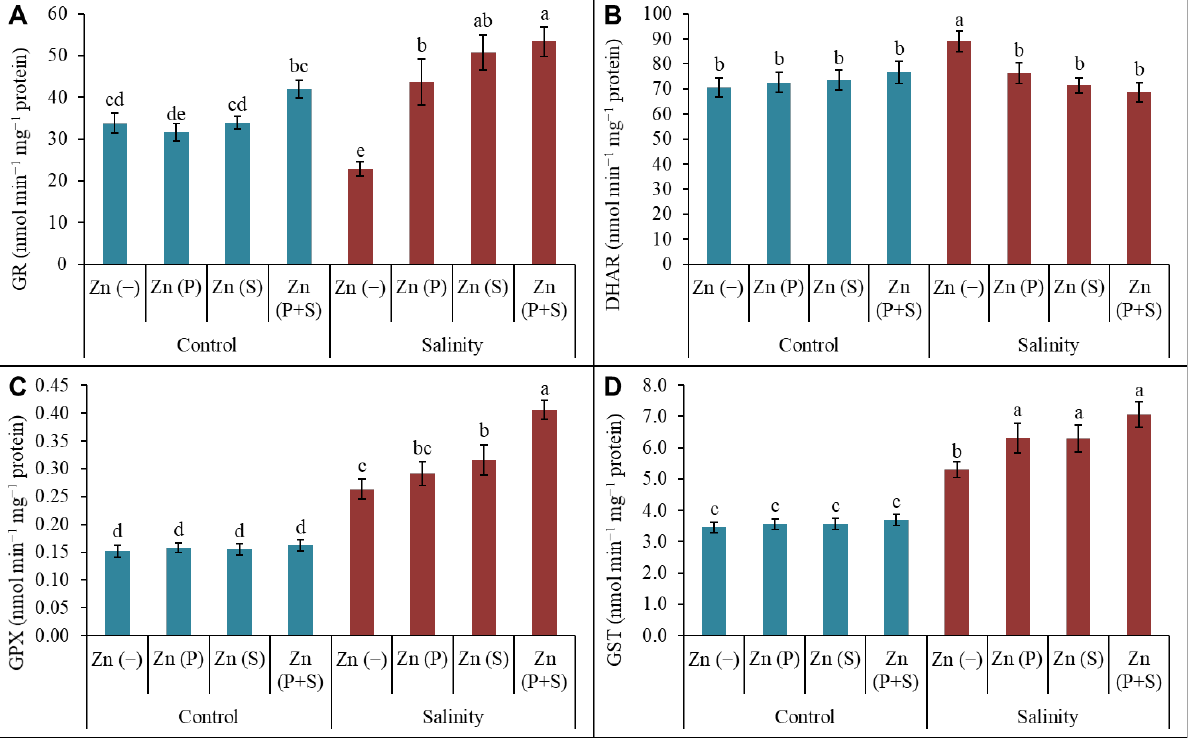
Figure 6. Activity of GR ( A ), DHAR ( B ), GPX ( C ) and GST ( D ) of soybean plants induced by Zn supplementation. Twenty five-day-old plants were subjected to salt (150 mM NaCl) and supple- mented with Zn (1 mM ZnSO 4 ·7H 2 O). P and S indicate seed priming and foliar application with Zn, respectively. Control treatments were grown with water. Mean (± SD) was calculated from three replicates for each treatment. Different letters of bars indicate significant differences at p ≤ 0.05 applying Tukey’s HSD test.